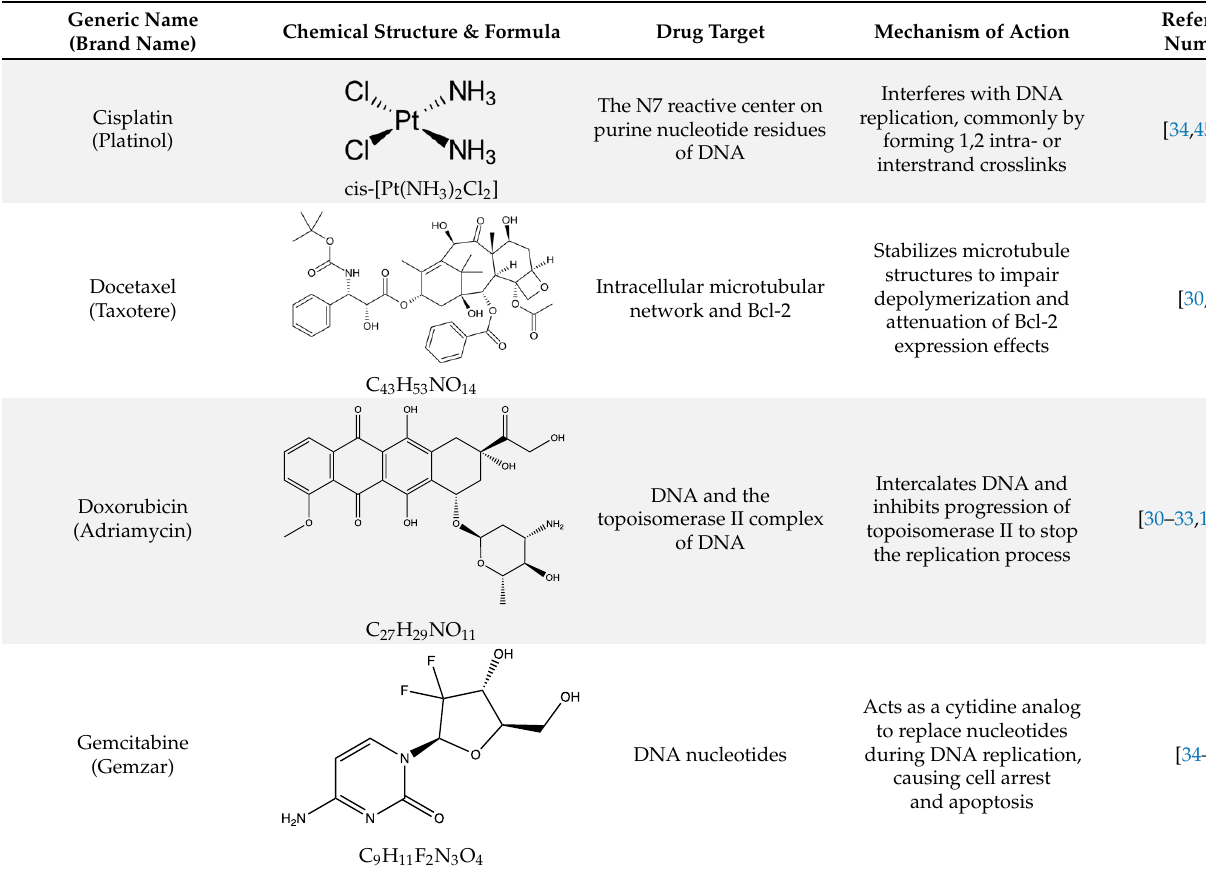
Table 1. Chemical structures and functions for standard chemotherapies, receptor tyrosine kinases, hormonal therapies, and monoclonal antibodies utilized to treat various cancers.